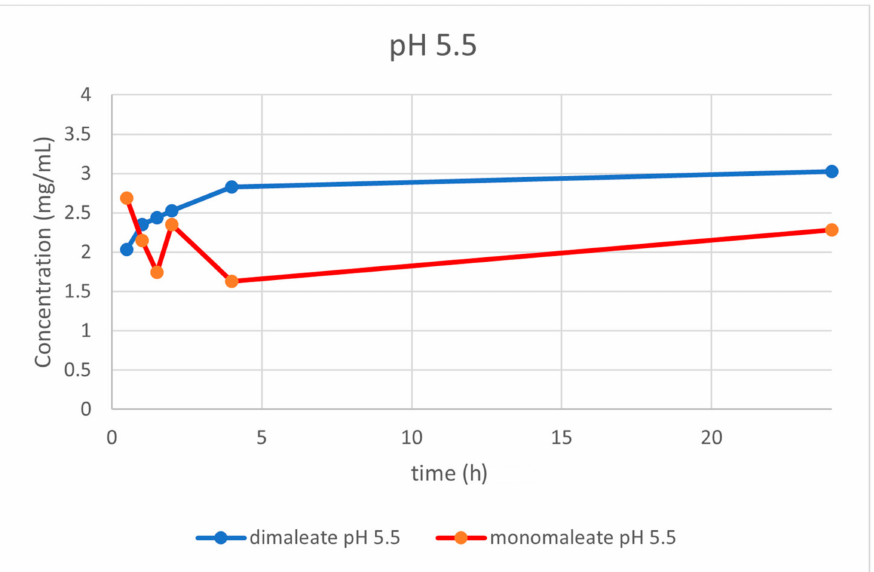
Figure 16. Dissolution testing of glasdegib monomaleate and glasdegib dimaleate at pH = 5.5. At pH = 7.0 (Figure 17), the dissolution curves revealed that solubility was rising slightly over time after 4 h for both forms. After 24 h, glasdegib monomaleate had slightly lower solubility (0.76 mg/mL) compared to the glasdegib dimaleate (0.79